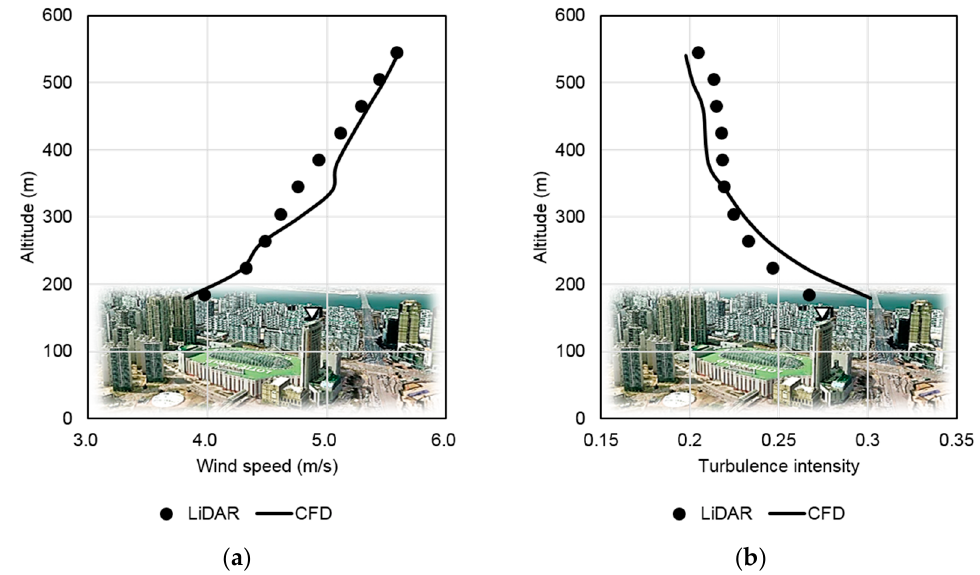
Figure 16. Comparison of the CFD simulations and the LIDAR measurements at the Lotte World Tower position: ( a ) mean wind speed profiles; and ( b ) turbulence intensity profiles.